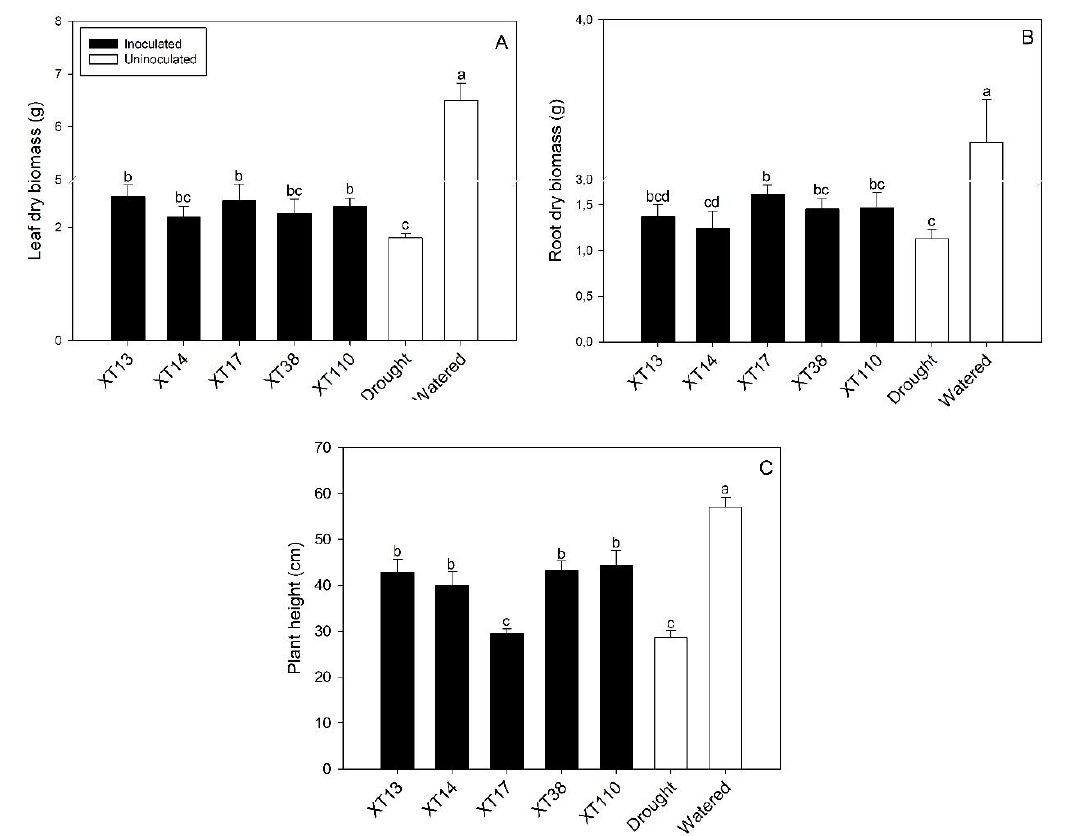
Figure 2. E ff ect of drought and Bacillus spp. inoculation on maize plants expressed as: ( A ) leaf dry biomass, ( B ) root dry biomass, and ( C ) plant height. Whiskers represent the standard deviation. Bars followed by the same letter are not significantly di ff erent at p ≤ 0.05 by Tukey’s test. Table 4. Influence of drought stress and Bacillus spp. inoculation on leaf uptake of P + , K + , and Ca 2 + in maize